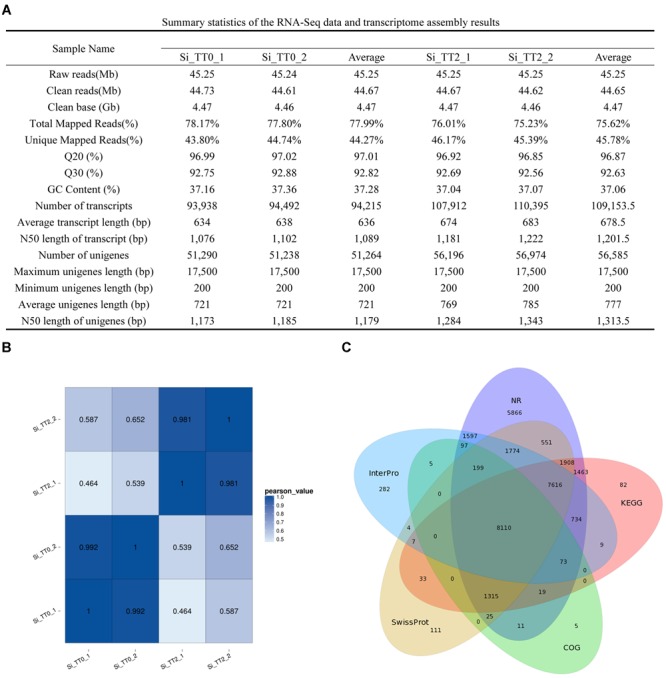
Summary statistics of the S. intermedius transcriptomes. (A) Summary statistics of the RNA-Seq data and transcriptome assembly results. (B) Pearson correlation coefficients between samples used in the current study. (C) Venn diagram showing NR, COG, KEGG, Swiss-Prot, and InterPro.